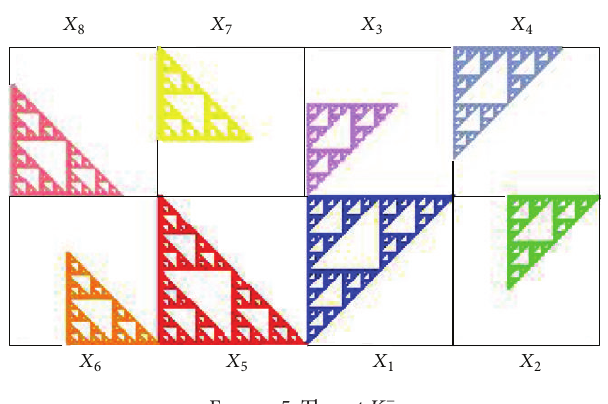
Figure 5: The set 𝐾 −